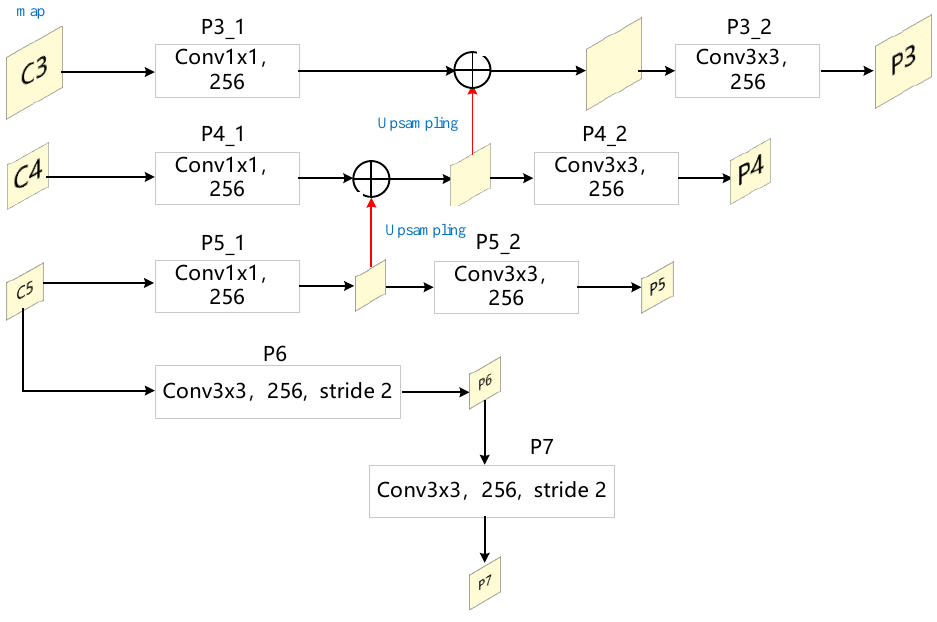
Figure 3. The structure of FPN given in